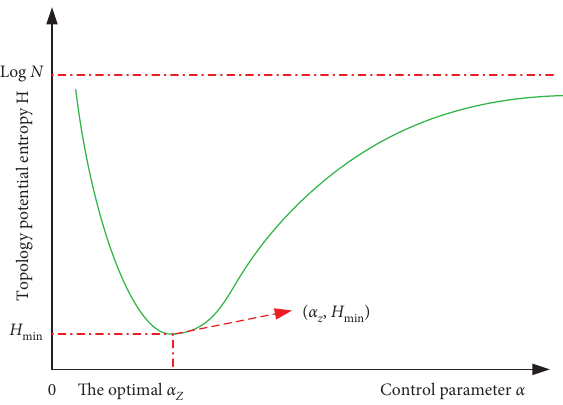
Figure 1: The curve of H with the control parameter α